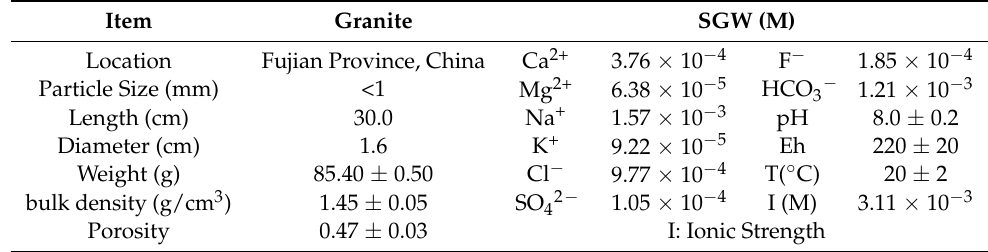
Table 1. The experimental crushed granite and synthetic groundwater (SGW) in this study. Item Granite SGW (M) Location Fujian Province,